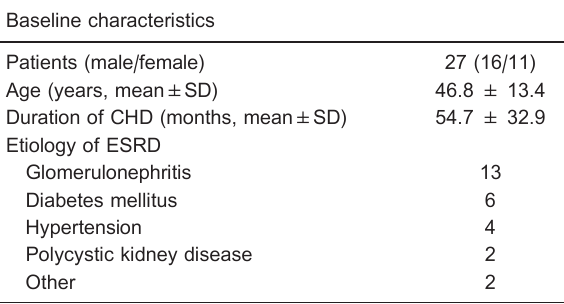
Table 1. Baseline characteristics of patients. Baseline